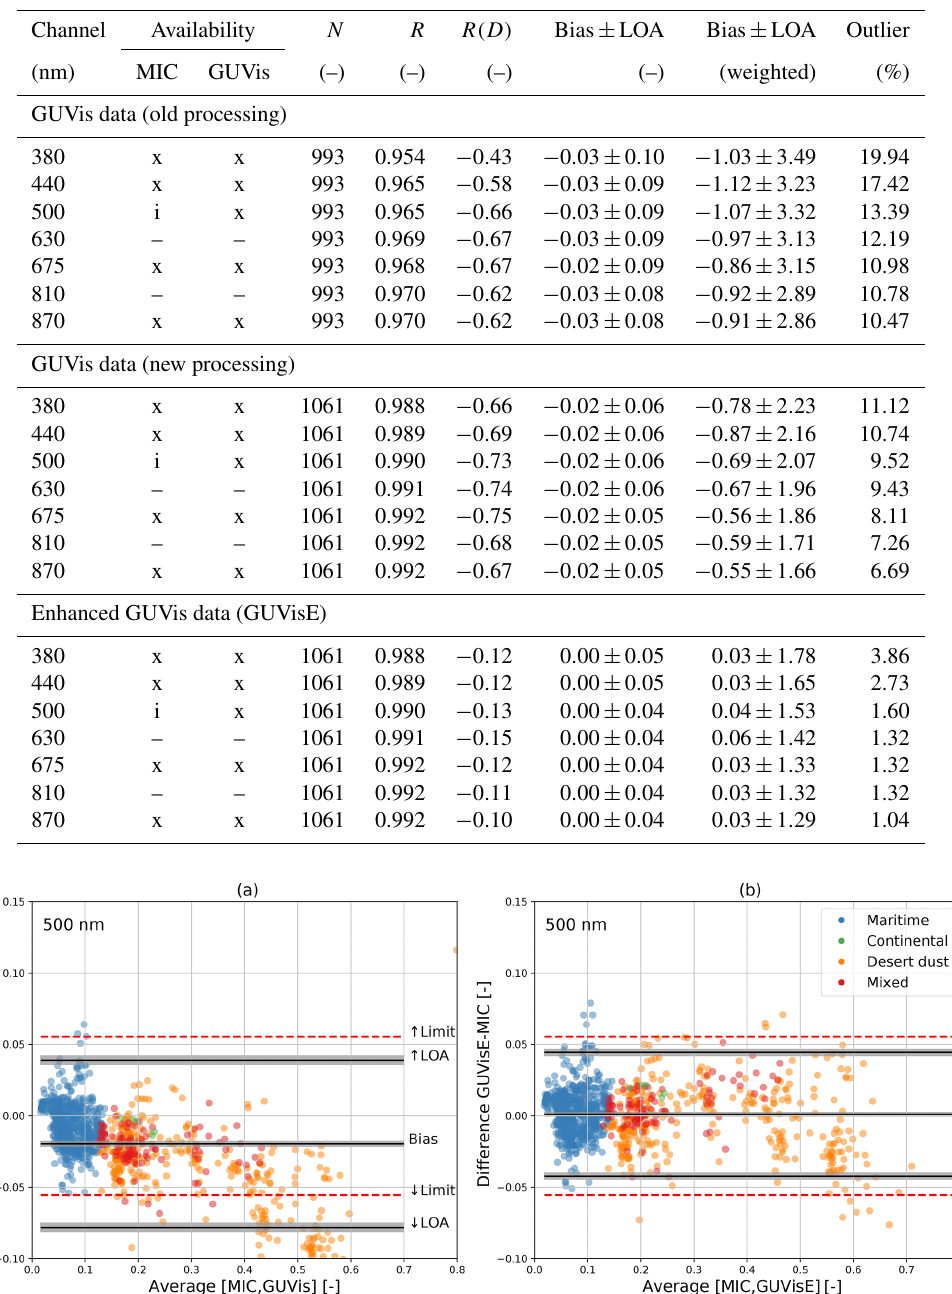
Figure 3. (a) Difference of the AOD between the GUVis and MIC datasets plotted versus their mean. (b) Difference of AOD between the GUVisE and MIC datasets plotted versus their mean. Blue and orange dots indicate maritime and desert dust, respectively. These data are considered as valid, while red dots are flagged as outliers (which exceed the uncertainty estimate in at least one of the considered spectral channels). The black lines indicate the bias and the upper and lower limits of agreement (LOAs), which should contain 95% of data points (see Sect. 3.3). The gray-shaded areas indicate the uncertainty estimate (95% confidence limit) of bias and